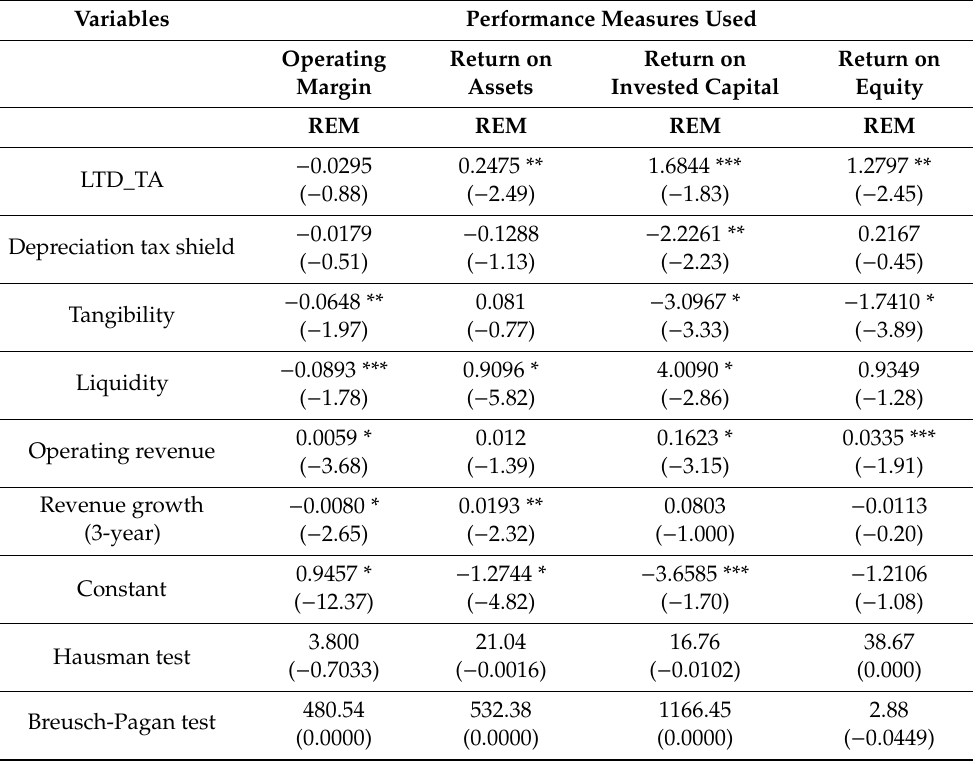
Table 9. Long-term debt and its e ff ect on firm